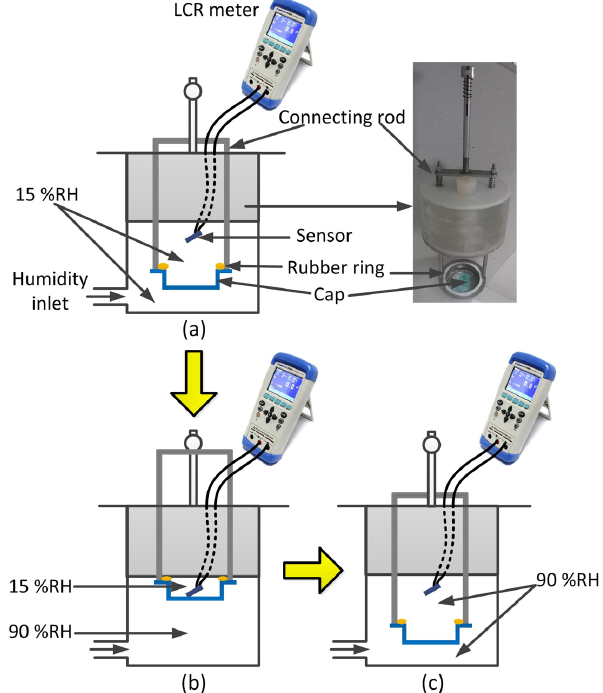
Figure 7. Test system of the humidity sensor for dynamic measurements. ( a ) The first step of the measurement; ( b ) The second step of the measurement; ( c ) The third step of the measurement.